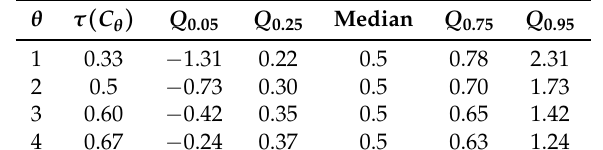
Table 6. Some percentiles of Y = X 1 / ( X 1 + X 2 ) , where ( X 1 , X 2 ) follows Clayton Copulas.